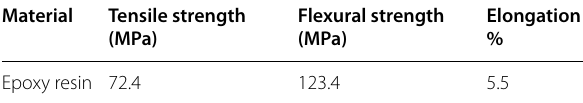
Table 5 Specification of epoxy